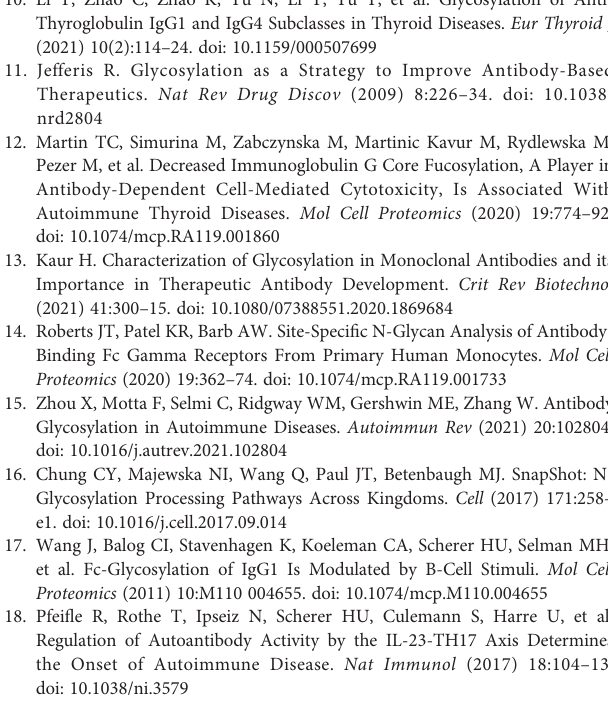
Supplementary Figure 1 | Determination of the optimal culture conditions. (A – D) Concentrations of IgG in the supernatant when primary B cells were treated with stimuli in a concentration gradient during the activation phase. (E – G) Concentrations of IgG in the supernatant when primary B cells were treated with stimuli in a concentration gradient during the differentiation period. The two-step in vitro B celldifferentiation system wasoptimized by concentration gradienttreatment with all stimuli. IgG secretion in the culture medium on day 12 was determined by ELISA. The error bars represent the SD. * p <0.05 vs. 0 ng/ml group, ** p <0.001 vs. 0 ng/ml group. Supplementary Figure 2 | Con fi rmation of glycosylation in IgG F(ab ’ ) 2 and Fc fragments. (A) Nonreducing SDS-PAGE gel stained with Coomassie brilliant blue, con fi rming that the full-length IgG molecule (left lane, 180 KD) was digested into F (ab ’ ) 2 (right lane, 130 KD) and the Fc fragment (right lane, 30 KD) by IdeS protease. (B) SNAlectinblottingwas performedtocon fi rmtheglycosylationofIdeSprotease- treatedpuri fi edIgG.IgGobtainedundercontrolconditionswasdigestedintoF(ab ’ ) 2 and Fc fragments. Three biological repetitions were performed. Supplementary Figure 3 | Percentage of CD19+ B cells in peripheral blood mononuclear cells (PBMCs). (A) Histrogram of PBMC from healthy donor detected by fl ow cytometry. (B) Percentage of CD19+ B cells in PBMCs. The bars show the means, and the error bars show the